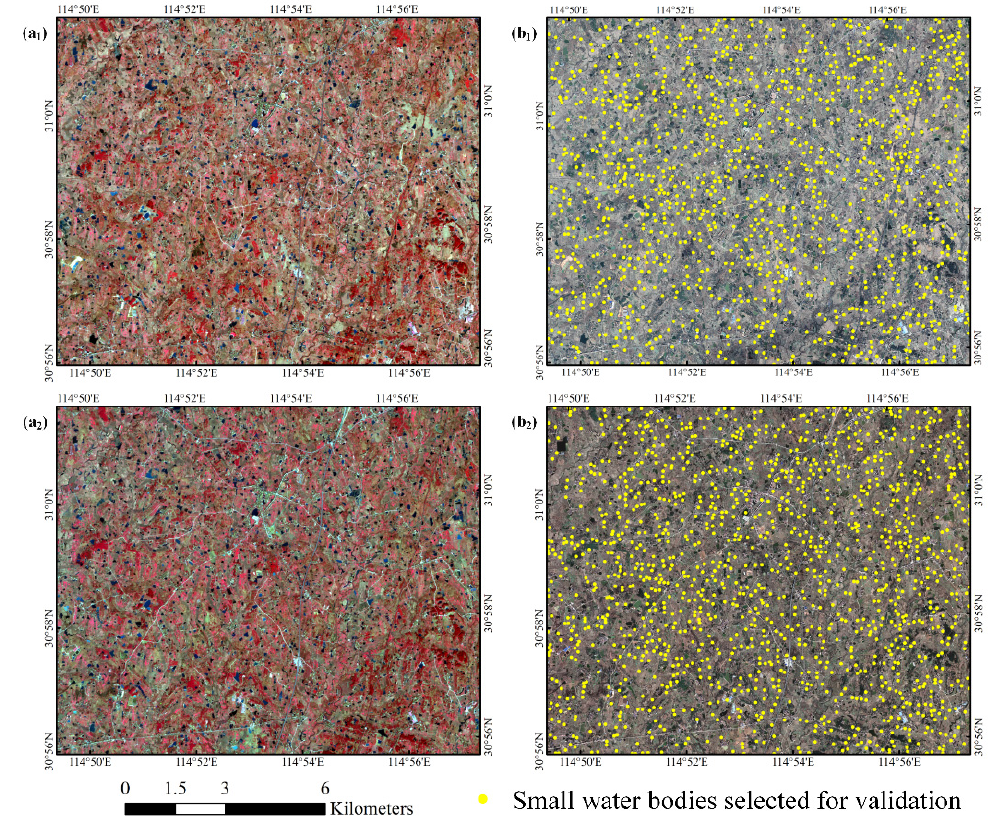
Figure 2. Data used in this study. ( a 1 , a 2 ) Sentinel-2 multispectral images used for surface water fraction mapping in 2017 and 2021 and ( b 1 , b 2 ) Google Earth RGB images used for validation in 2017 and 2021. Small water bodies (SWBs) sampled for validation are highlighted as yellow points.